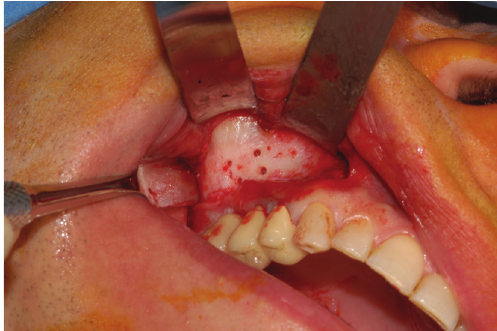
Figure 5: The bony window is left pedicled to the Schneiderian